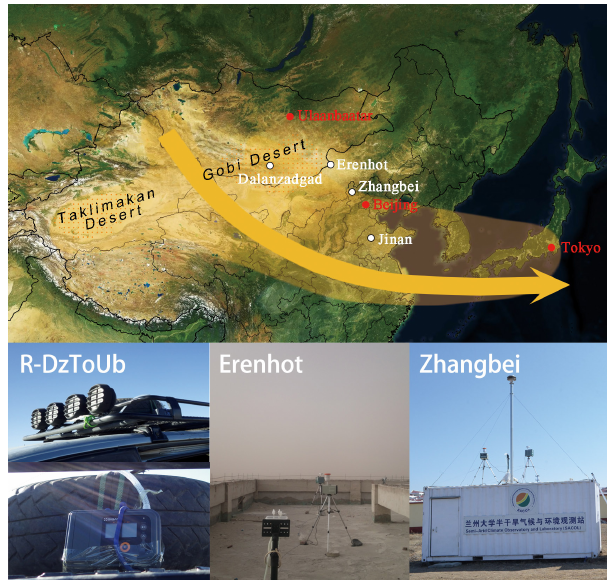
Figure 1. The design of the Dust-Bioaerosol Campaign 2016, the locations of the sampling sites, and the contexts of the bioaerosol samplers (R-DzToUb is located along the road between Dalan- zadgad and